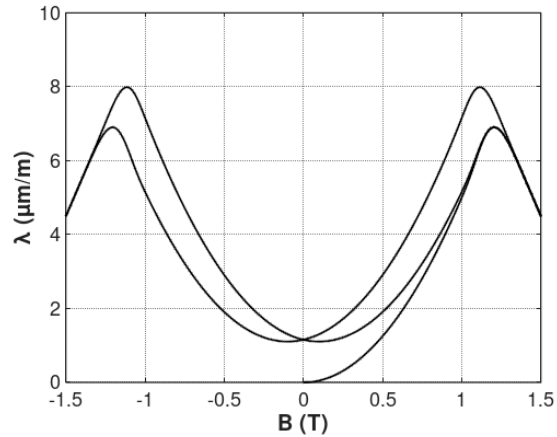
Figure 5. Magnetostrictive λ (B) hysteresis loop, determined by Equation (12), calculated for the parameters: a 1 = 5 µ m